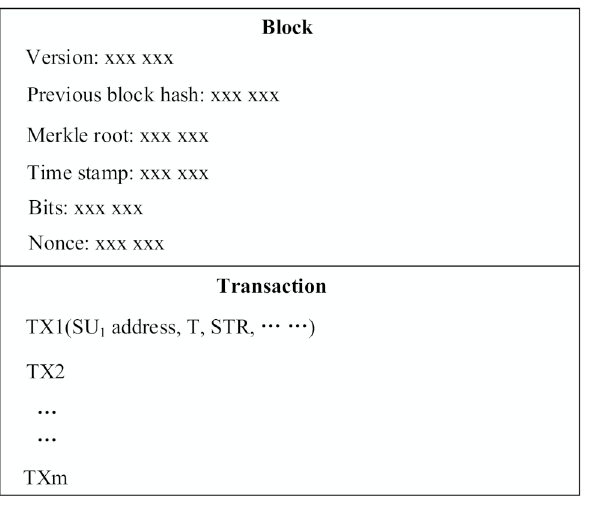
Figure 2. Structure of block.